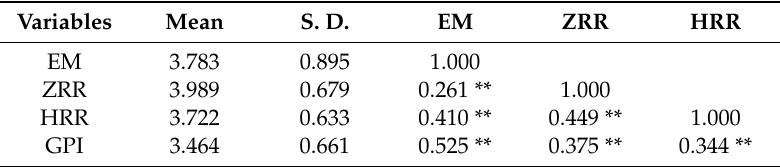
Table 1. Results of correlation analysis of